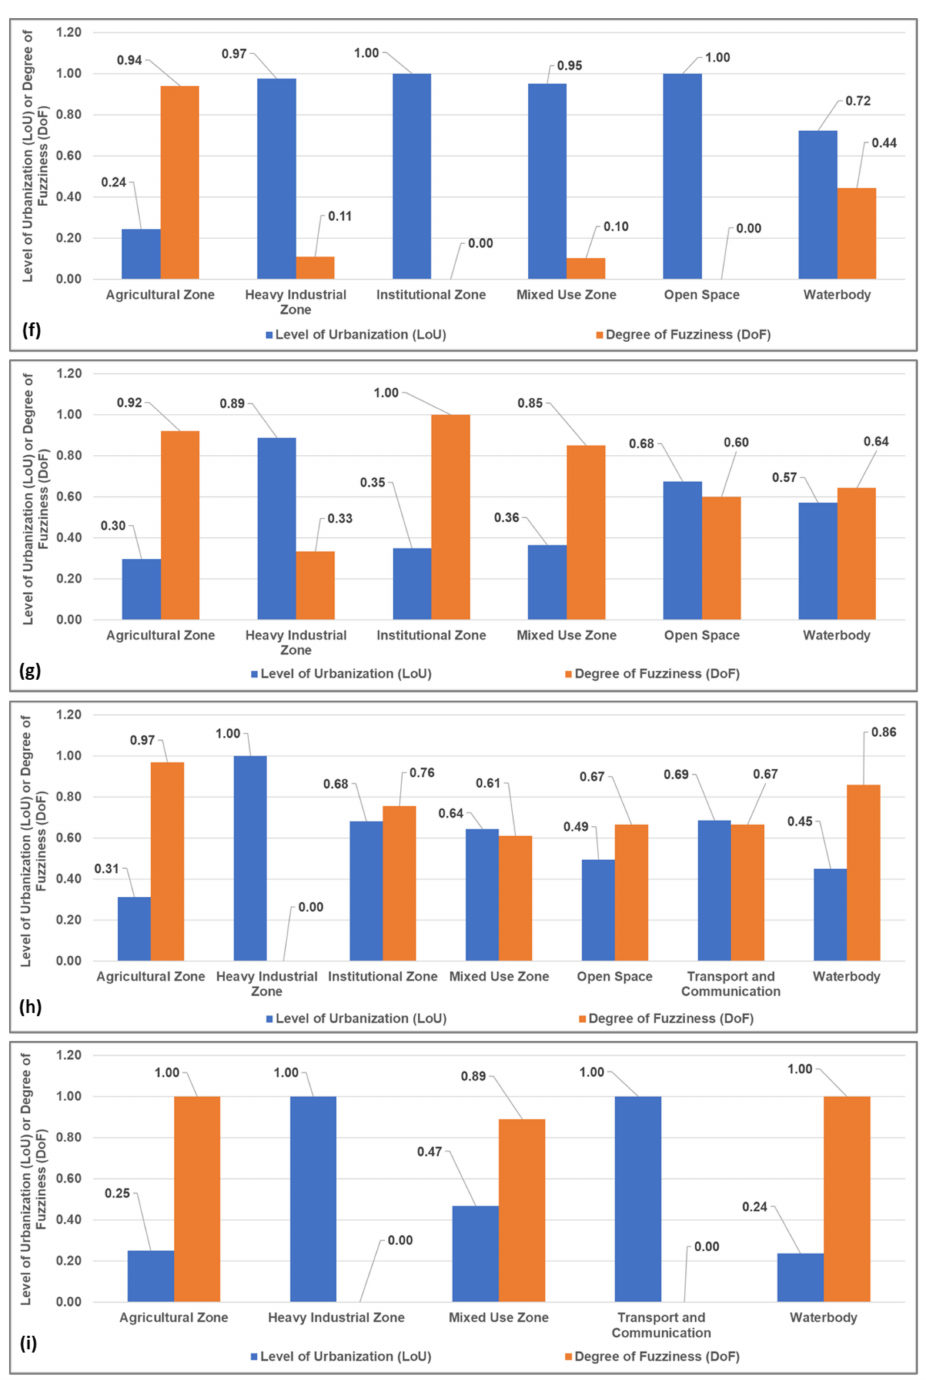
Figure 13. The level of urbanization (LoU) and degree of fuzziness (DoF) for CRDP’s 2015–2035 proposed land use zones: ( a ) Bandar; ( b ) Dhaka Metropolitan Area (DMA); ( c ) Gazipur Sadar; ( d ) Kaliganj; ( e ) Keraniganj; ( f ) Narayanganj Sadar; ( g ) Rupganj; ( h ) Savar; and ( i ) Sonargaon. Such general findings are also evident in the sub-district-wise LoU and DoF calculations that were derived from the NTL VIIRS data mapping of 2016 (Figure 9). Thus, it can be deduced that the proposed NTL data mapping exercise of 2016 yields substantive outcomes in distinguishing predominantly rural, peri-urban, and predominantly urban